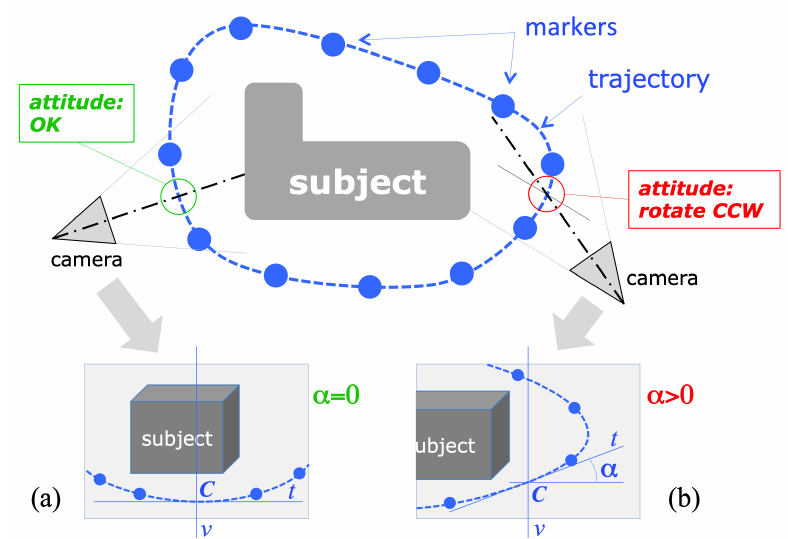
Figure 3. Schematization of the acquisition geometry, for the estimation of the actual camera attitude. The angle α (defined in the images as the angle between the tangent to the trajectory in C and the horizontal) is a measure of the deviation from the correct attitude: ( a ) α = 0: correct attitude; ( b ) α > 0: drone should rotate to the left (counter-clockwise yaw